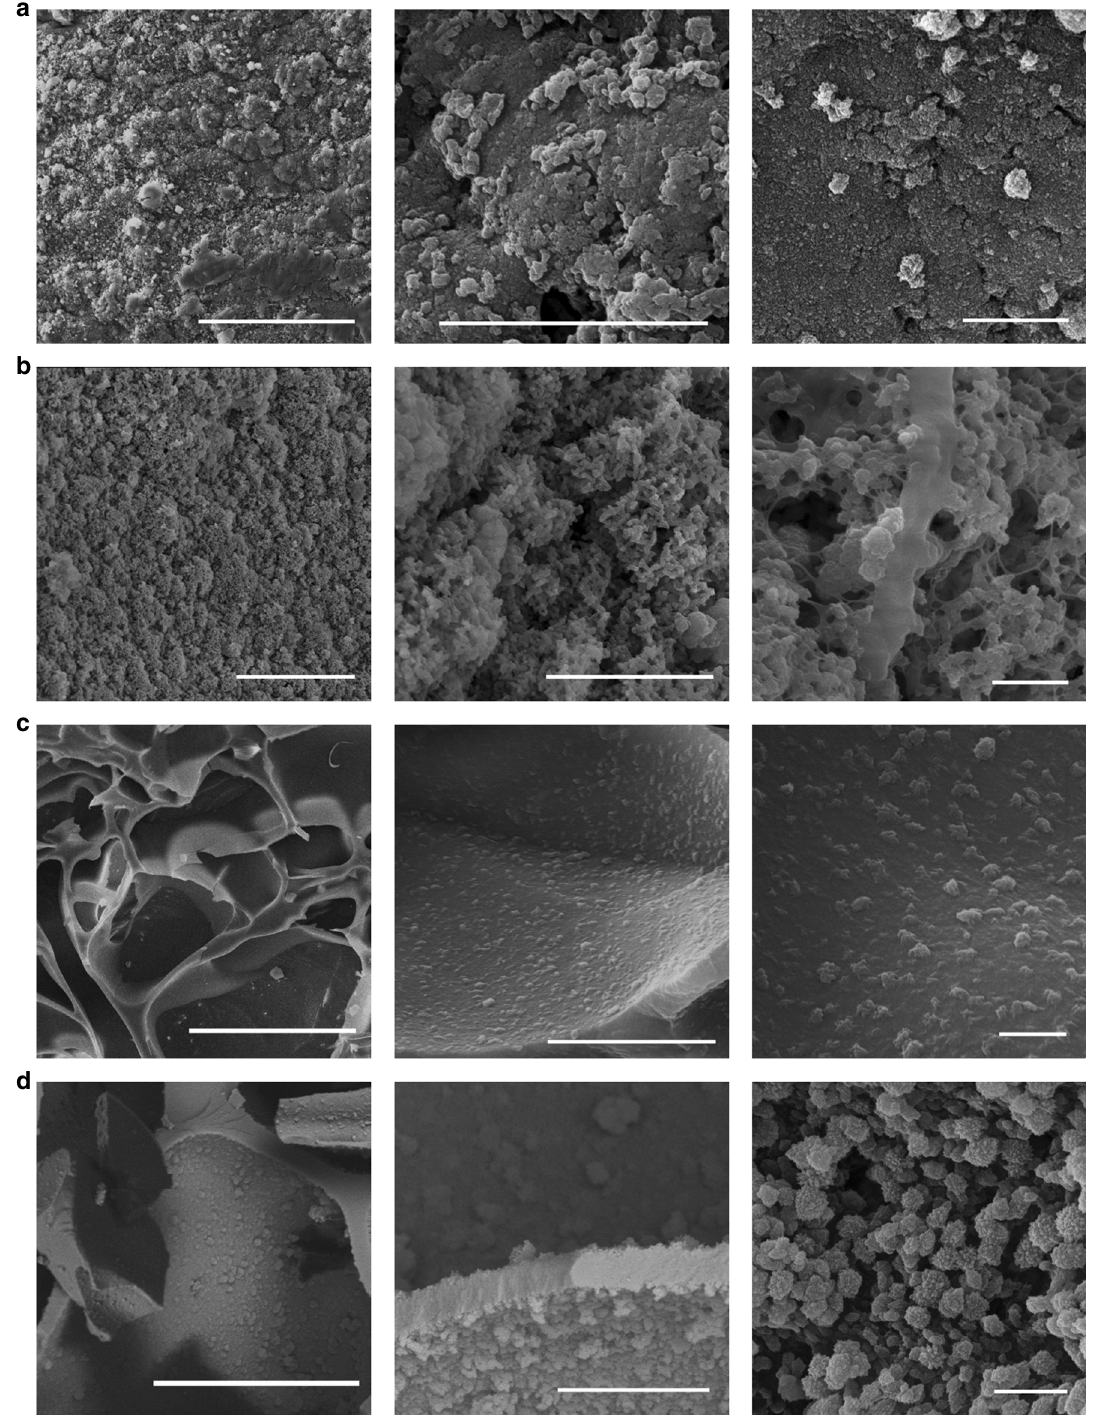
Fig. 3 SEM cross-sectional images of β -sheets-incorporated hydrogel. a , b Hydrogels and c , d cryogels with different content of β -sheets, CB60 ( a , c ) and CB360 ( b , d ). From left to right, scale bars are 50 μ m, 5 μ m and 1 μ m with increasing magni fi